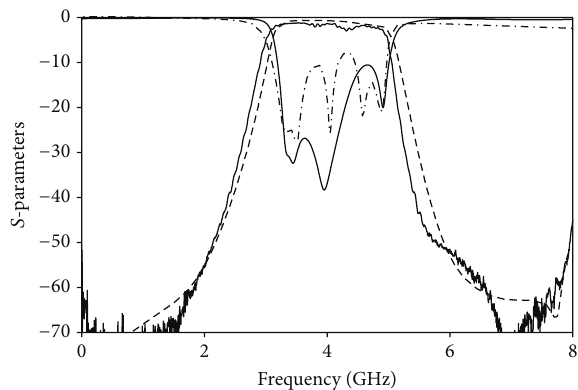
Figure 4: measured S21 (solid thick line), simulated S21 (dashed line), measured S11 (dash-dotted line), and simulated S11 (solid thin line).